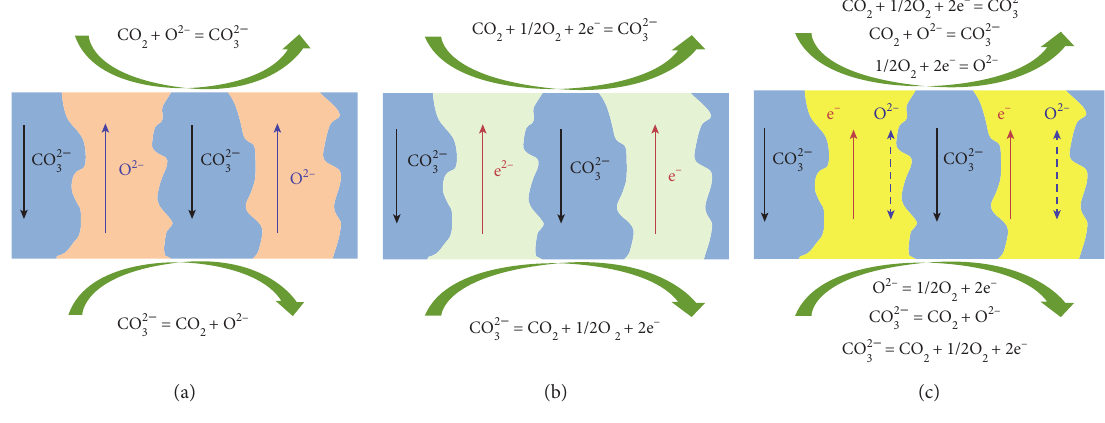
Figure 3: CO 2 transport mechanisms: (a) MOCC, (b) MECC, and (c) MEOCC [16]. Table 1: Melting points of pure salts of carbonates and various eutectic mixtures